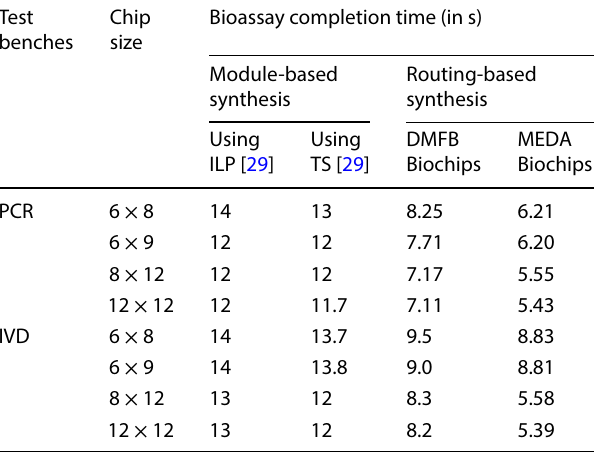
Table 7 Comparison between synthesis termination times and vari- ous chip sizes of IVD and PCR, respectively Test benches